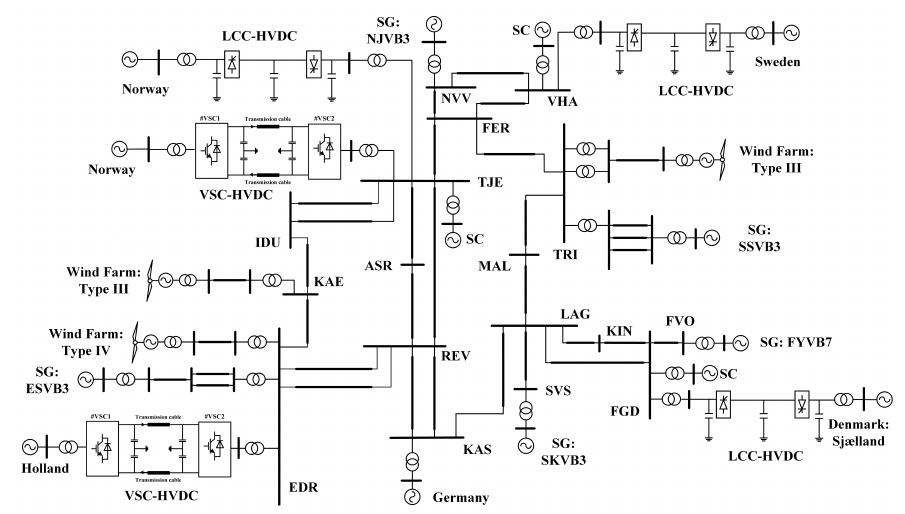
Figure 11. Single-line diagram of the western Danish power system.